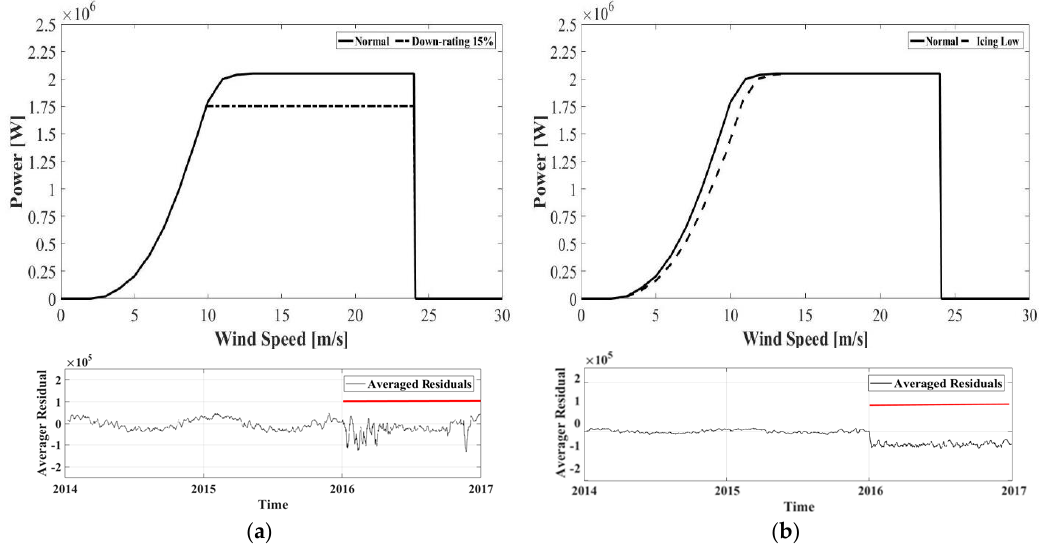
Figure 7. Examples of reference fault power curves: ( a ) Down-Rating with power curves for Normal, 15% fault signatures and residual generated for Down-Rating 15% using Method 1 ( b ) Icing with power curves for Normal, icing low fault signatures and residual generated for Icing 5% using Method 1.